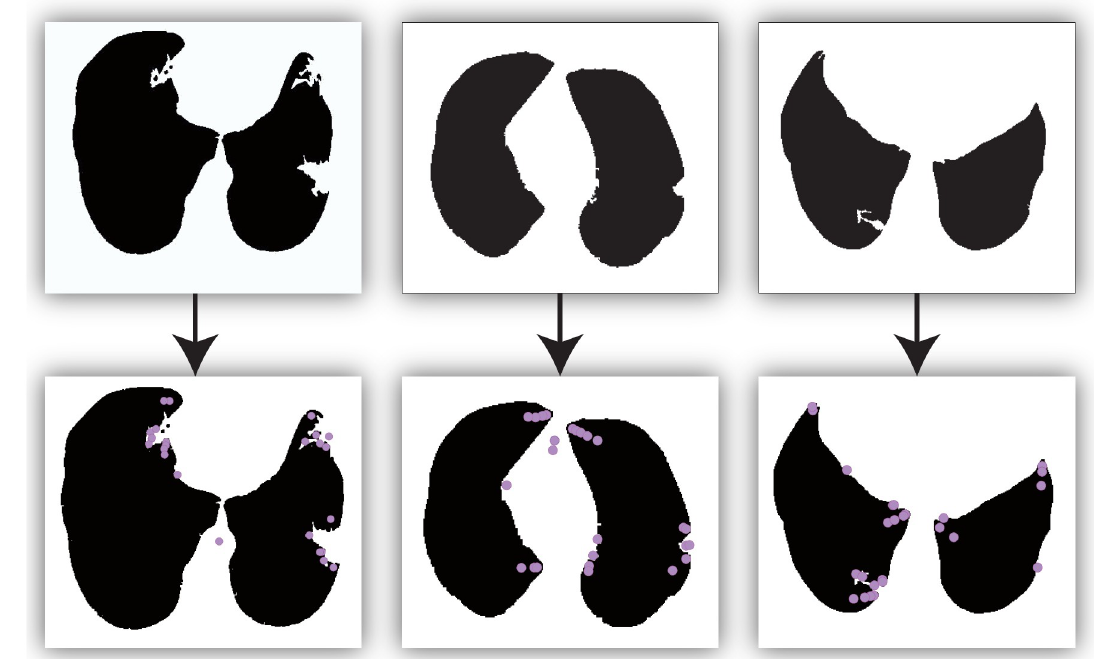
Fig 3. The detected SIFT points of the three